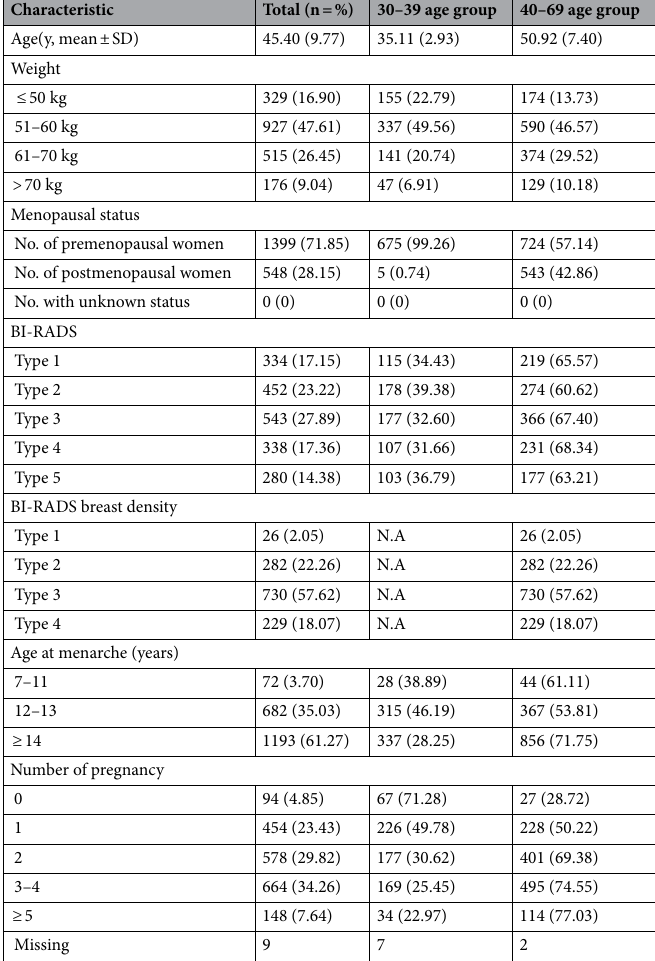
Table 1. Patient demographic and clinical characteristics at